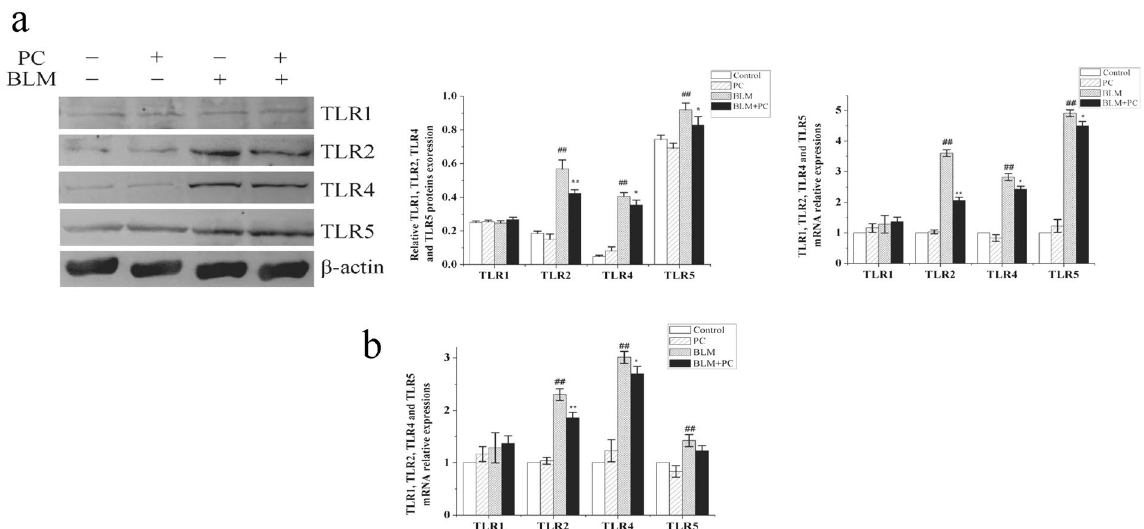
Figure 6. Effects of PC on TLR1, TLR2, TLR4 and TLR5 in the lung tissues induced by BLM. WT mice were killed after BLM exposure for 7 days and 28 days. TLR1, TLR2, TLR4 and TLR5 were analysed in terms of their protein expression levels through Western blot and (or) RT-PCR. ( a ) 7 days. ( b ) 28 days. Data were expressed as mean ± SEM. ## p < 0.01 compared with the control group, ** p < 0.01 compared with the BLM